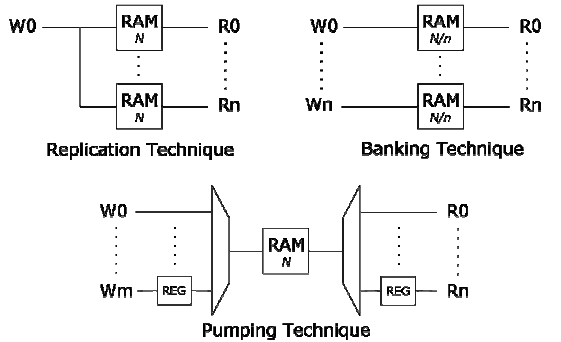
Figure 8. Multi-port emulation techniques using dual-port modules.